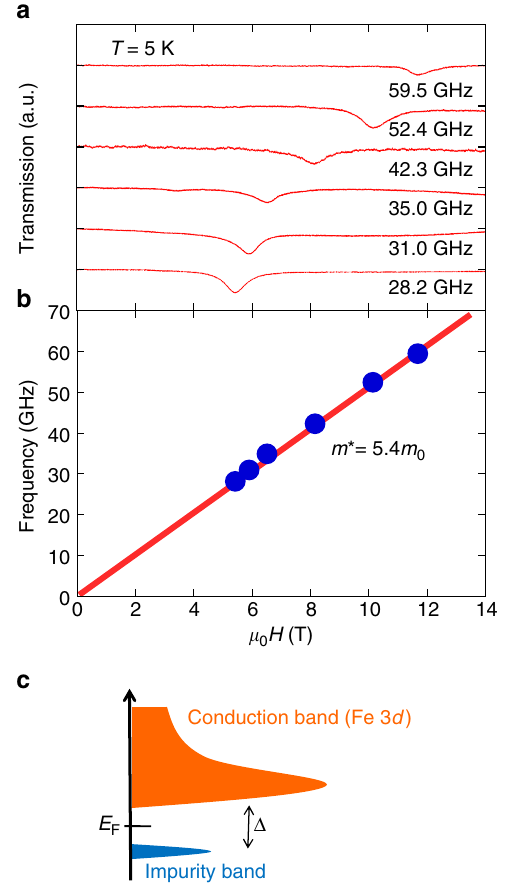
Figure 4 | CR measurement. ( a ) CR spectra at 5K at the designated frequencies. ( b ) Frequency versus magnetic field plot of the CR fields obtained from the data in a . Straight line gives a cyclotron effective mass m * of 5.4 m 0 (where m 0 is the bare electron mass). ( c ) Band diagram of FeSb 2 ; a small energy gap D appears between the conduction and impurity bands 15,18,27 . The conduction band may possess a steep band edge associated with the localized Fe 3 d orbitals, leading to the large electron